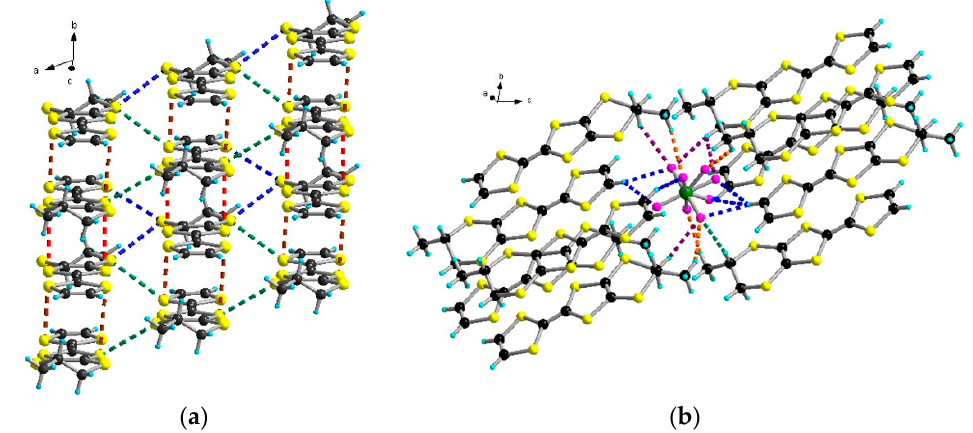
Figure 2. ( a ) Layer of donors in the packing of [( S )- 1 ] 2 AsF 6 with an emphasis on the S···S short con- tacts: red dotted lines (3.55–3.59 Å), brown dotted lines (3.62 Å), blue dotted lines (3.60–3.63 Å) and green dotted lines (3.68–3.70 Å); ( b ) C–H···F short contacts: blue dotted lines for CH vinyl (2.40–2.44–2.53 Å), orange dotted lines for Me (2.42–2.55 Å), violet dotted lines for CH 2 (2.49–2.66 Å) and green dotted lines for CH Me (2.53 Å).